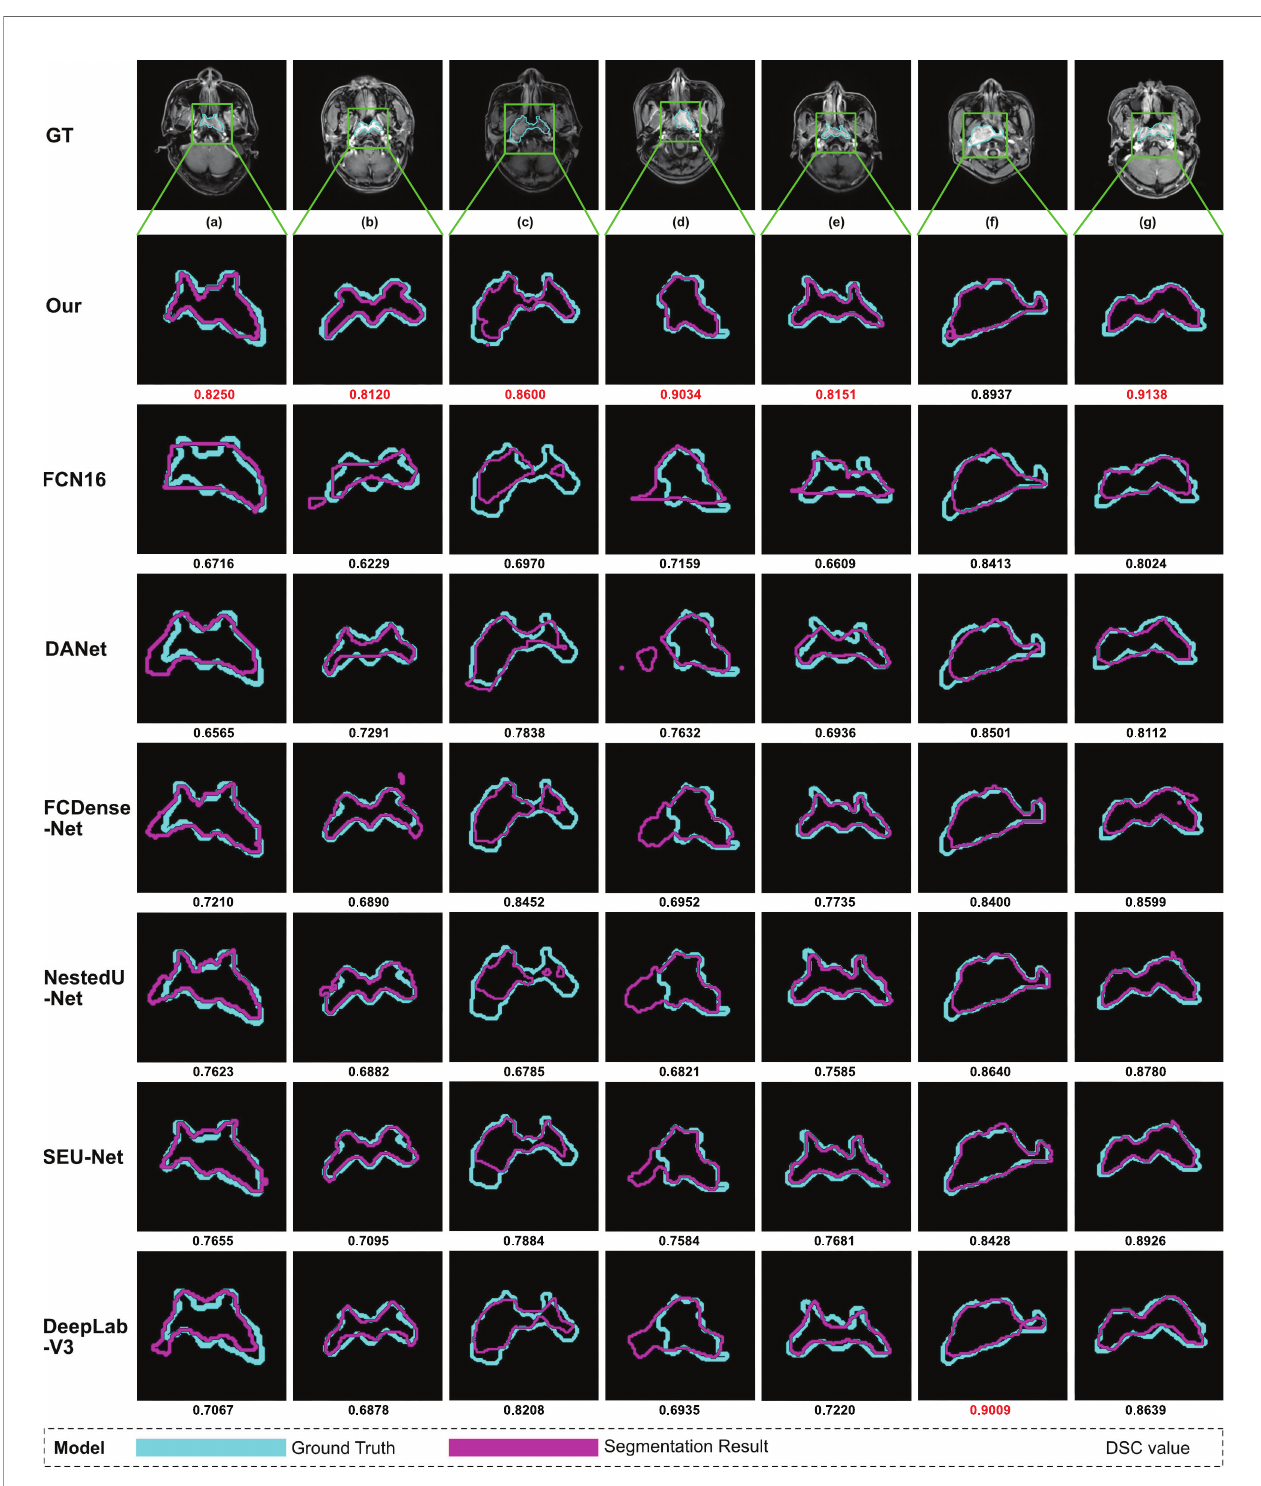
FIGURE 5 | Examples of NPC segmentation results: We select seven typical MRI images of nasopharyngeal carcinoma and present the segmentation results of our model and seven models used for comparison. From top to bottom, the manual segmentation results and model segmentation results of our model, SEUNet, DANet, FCDenseNet, NestedUNet, DeepLabV3, and FCN16, respectively. For each MRI image of nasopharyngeal carcinoma, we draw the manual segmentation boundary with skyblue contours and the segmentation boundary of the corresponding model with purple contours and then calculate the DSC value, which is displayed below the image. We mark the maximum DSC value for each image in